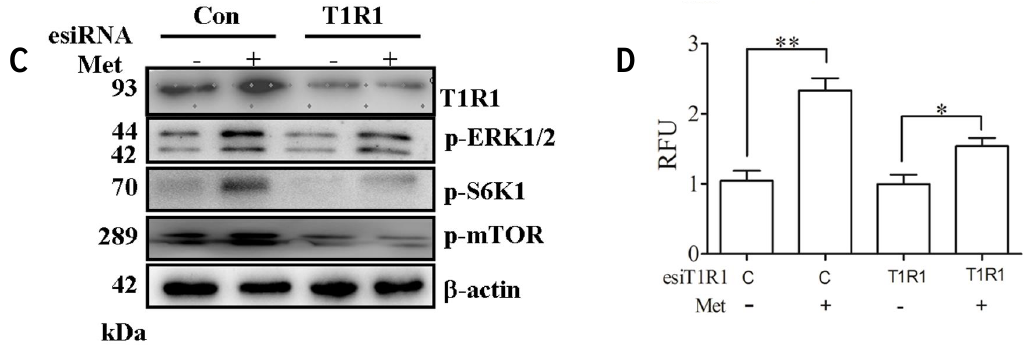
Figure 4. Met activates ERK1/2 and mTORC1 through the T1R1/T1R3 receptor. Serum-starved C2C12 myoblasts in KRBH were treated with 1 mM/L IMP for 15 min prior to treatment with 50 mM Met for 60 min. p-S6K1 and p-mTOR protein levels were analyzed by Western blotting, and β -actin was used as a loading control ( A ); C2C12 myoblasts were treated as in ( A ), loaded with Fluo8-AM, and pretreated with disodium 5 (cid:48) -inosinate (IMP) for 30 min prior to Met stimulation. Data are the mean ± SEM of the relative fluorescence units (RFU) values of three independent experiments ( B ); The control (Con) esiRNA and T1R1 esiRNA (Sigma, St. Louis, MO, USA) were transfected into C2C12 myoblasts in KRBH were stimulated with 50 mM Met for 60 min. T1R1, p-ERK1/2, p-S6K1, and p-mTOR protein levels were analyzed by Western blotting, and β -actin was used as a loading control ( C ). C2C12 myoblasts were treated as in ( C ) and loaded with Fluo8-AM; Data are the mean ± SEM of the RFU values of three independent experiments ( D ). “+” means to add, “-” means not to add. Results were represented as mean ± SD, * p < 0.05, ** p <